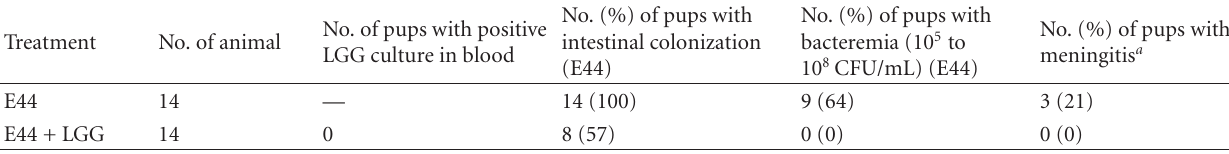
Defined as positive culture of